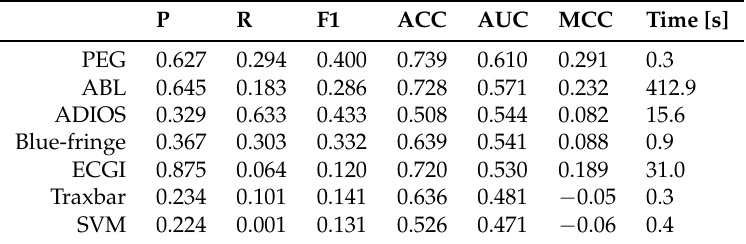
Table 5. Results of classification quality for the test set by the decreasing AUC.